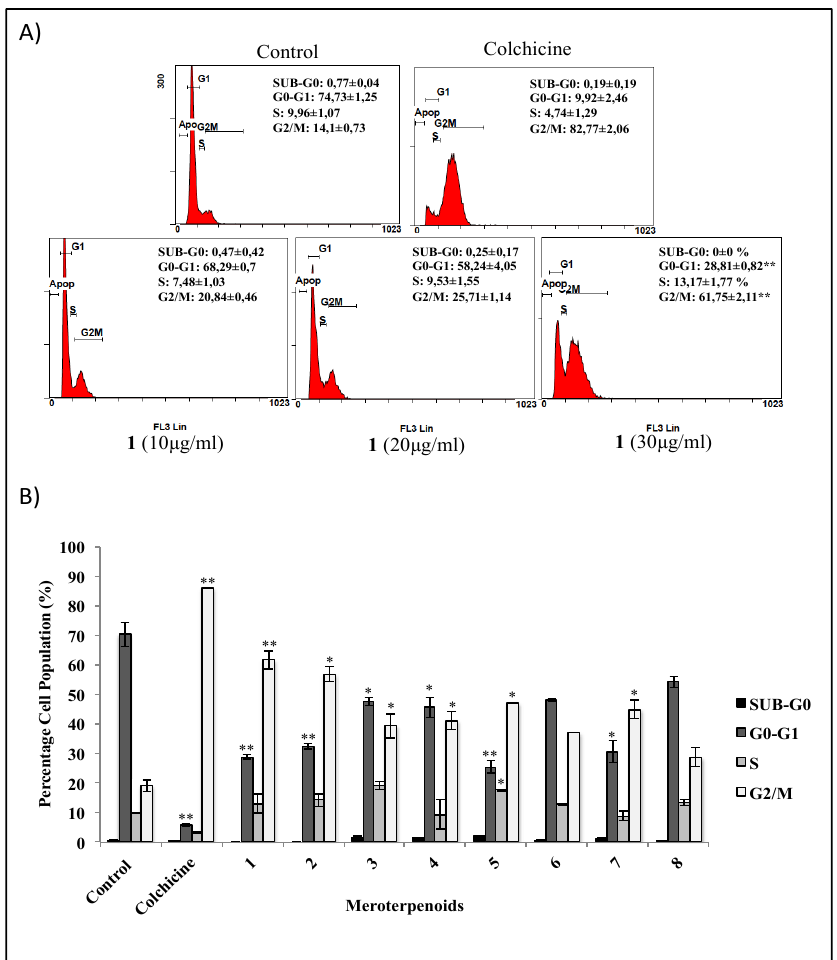
Figure 4 . Flow cytometry analysis of cell cycle arrest in colon cancer cells HT-29 treated for 24 h with the meroterpenes (AMTs) 1 - 8 . Negative control cells received no treatment. Positive control received 0.2 μ g/mL of colchicine. ( A ) Representative flow cytometry histograms, for cell cycle phase (percentages in Sub-G0, G0-G1, S, and G2/M,) showing HT-29 cells treated with 10, 20, and 30 μ g/mL of compound 1 . ( B ) Similarly, bar charts for HT-29 cells treated with 30 μ g/mL of 1 , 2 , 5 , 6 , 7 , and 8 , and 90 μ g/mL of 3 and 4 . Data represent mean ± SE from three independent experiments. Significant differences to control group: * p < 0.05 and ** p < 0.01. 3.4. Effects of the AMTs 1 - 8 on the migration and invasion of HT-29